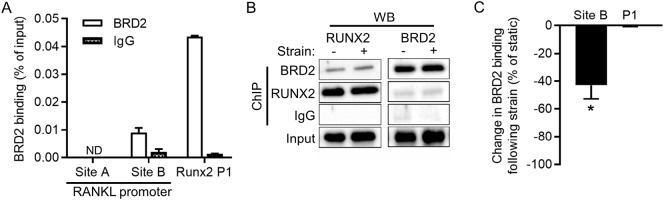
BRD2 binding to the RANKL promoter is down-regulated by strain. Saos-2 were subjected to strain and harvested 8 h later for ChIP analysis using a BRD2 and IgG antibodies. Quantification of ChIP precipitates with primers for the RANKL promoter sites A and B or the RUNX2 P1 promoter (ND = not detected) (A). Western blot analysis of ChIP lysates or Input loading control (B). Percentage change in BRD2 occupancy of the RANKL Site B and RUNX2 P1 (C). Bars represent the mean ± SEM, n = 3 representing three independent experiments. *p < .05 versus static control.